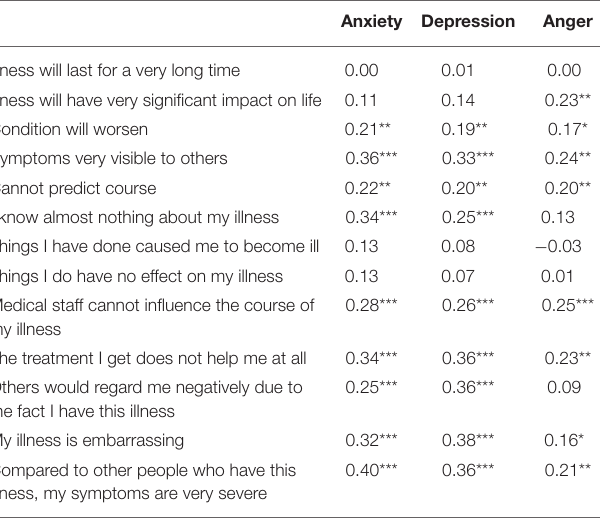
TABLE 3 | Partial correlations between the outcome variables (depressive symptoms, anxiety, anger) and illness-related beliefs (controlling for both sociodemographic and clinical variables).